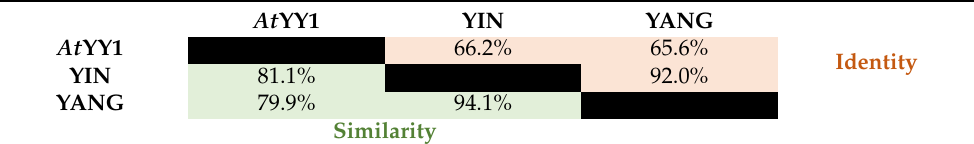
Figure 2. Sequence alignment and prediction of conserved domains in YY1 homologs of the Salicaceae family and At YY1. The amino acid sequences were aligned with DNAMAN, modified. The REPO domain [23] is marked in dark-blue, the Zn-finger domains (ZF) are marked by green lines, the CKII phosphorylation site (CKII) by a red line (the asterisk marks the phosphorylated amino acid), the NLS by a black line, and the C-terminal acid-stretch by a line in ultramarine. Identical and similar amino acid residues are shaded with dark-blue, pink, and light-blue, respectively. At YY1, Arabidopsis thaliana ; YIN, YANG, Populus ( Populus trichocarpa ); Pd YY1a,b, Populus deltoides ; Sp YY1a,b, Salix purpurea . Table 1. Similarity and identity of At YY1, YIN, and YANG.